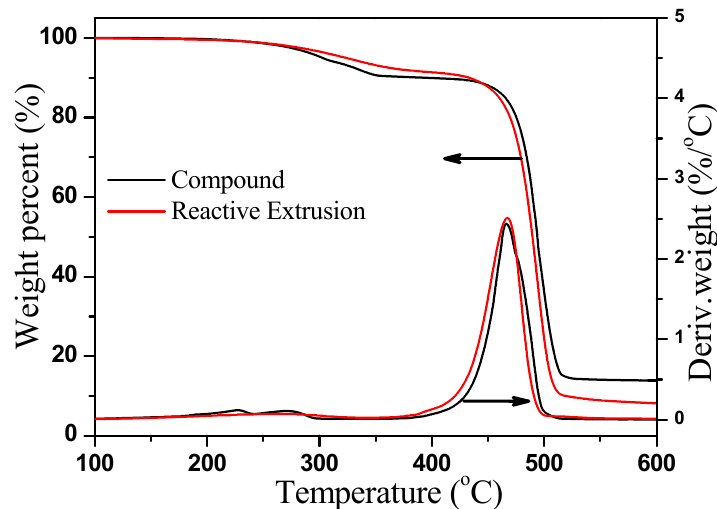
Figure 6. TGA and DTG curves of reactive extruded and compound EPDM/PP/IFR composites with 25% content of IFR (MP/PER).